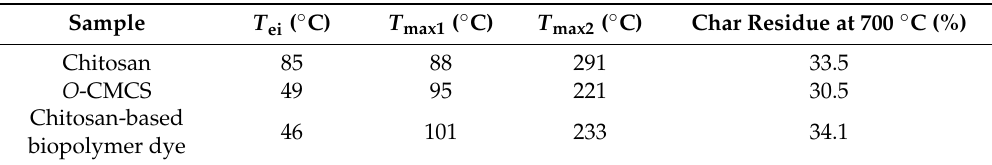
Table 1. Thermogravimetric parameters for thermal degradation of chitosan, O -CMCS, and chitosan-based biopolymer dye.